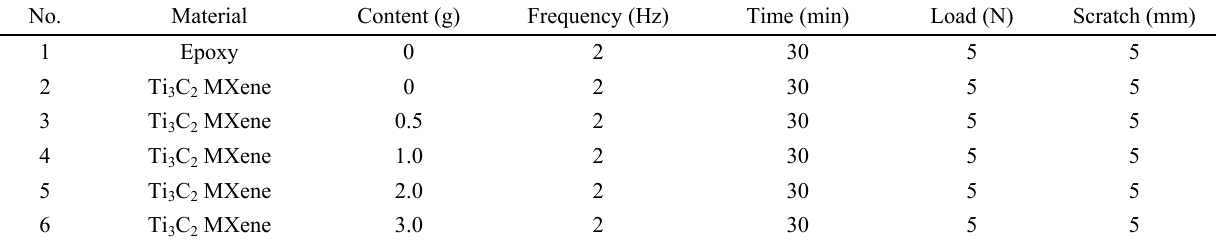
Table 1 Friction and wear test parameters of different content of few-layer Ti 3 C 2 MXene.